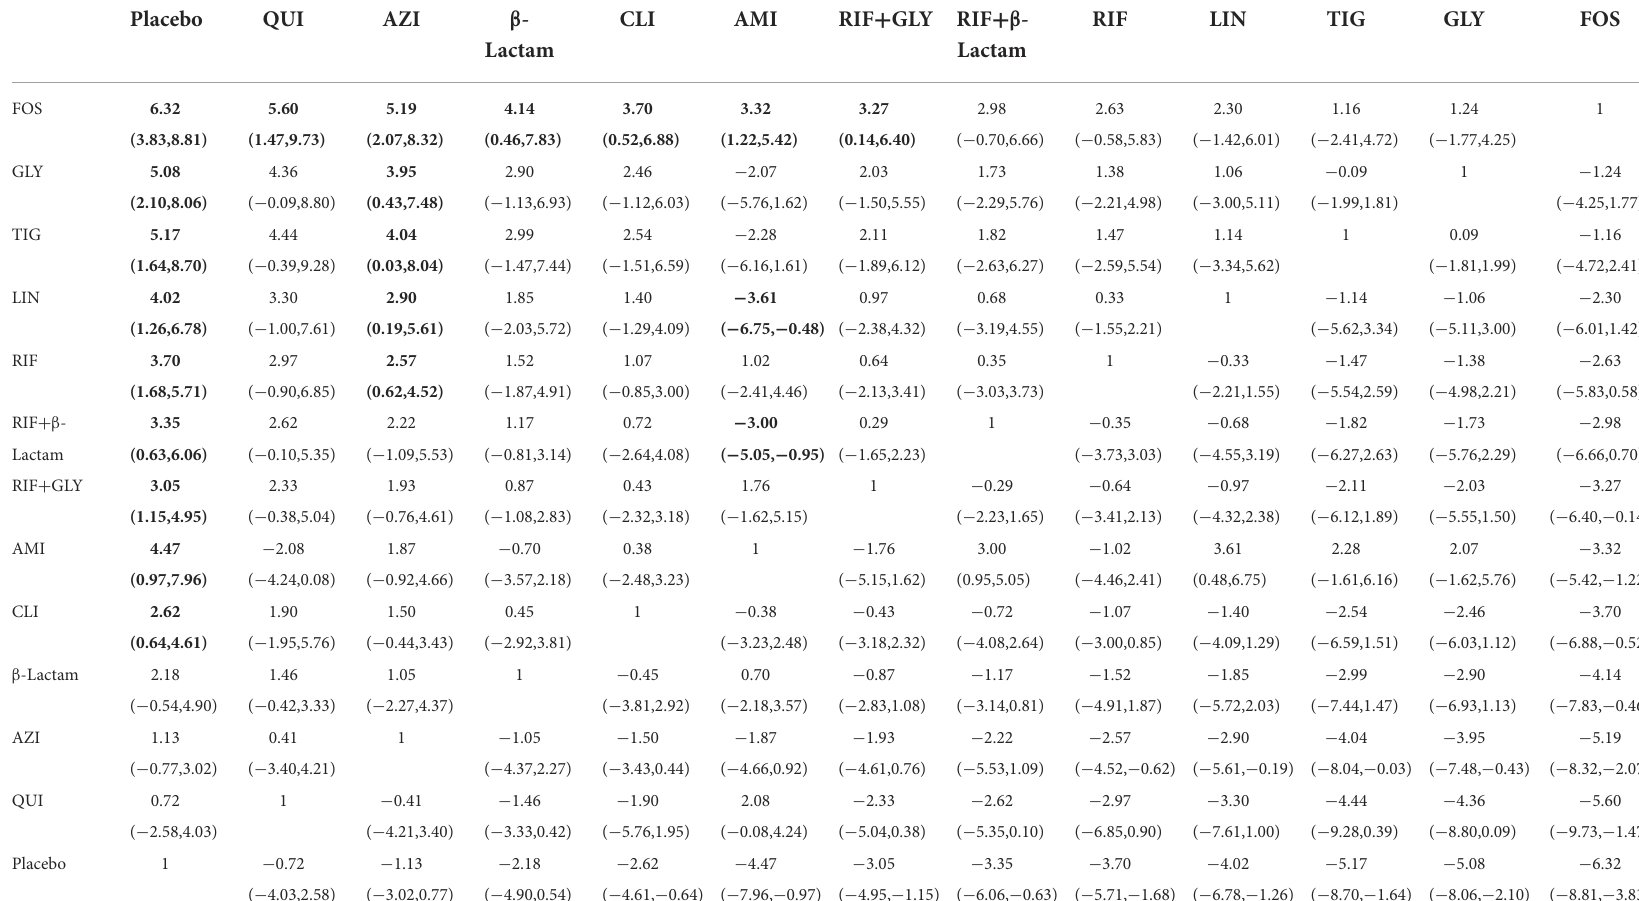
TABLE 3 Matrix of pairwise comparations of regimens on bacterial counts [shown as SMD (Standardized mean difference) and 95% confidence intervals (CIs)].